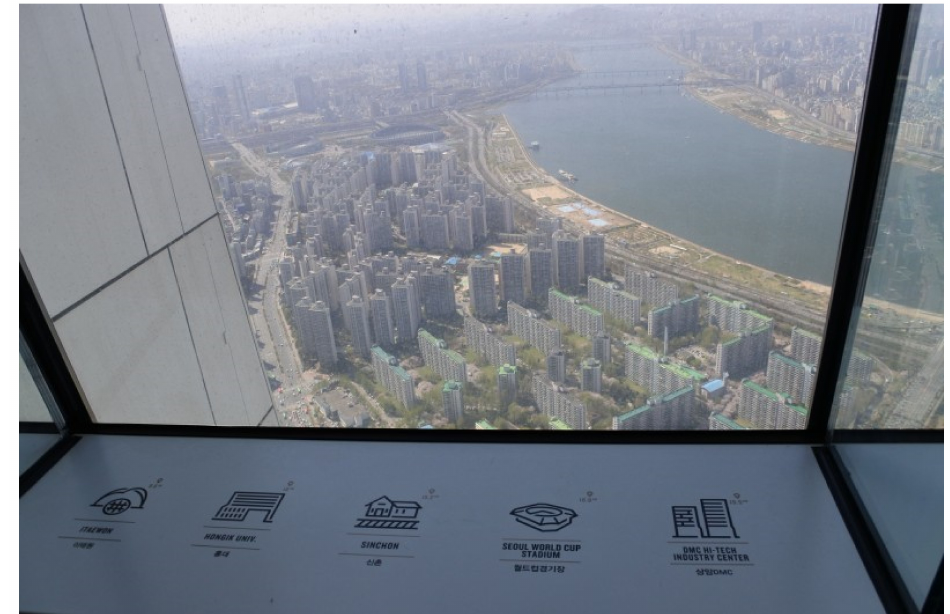
Figure 2. Visitors can view a 360 ◦ landscape of Seoul from the Seoul Sky Observatory; landmark icons for the main buildings and places in Seoul are placed below each window to help visitors pick out these buildings and places from the corresponding directions at the 118th floor.